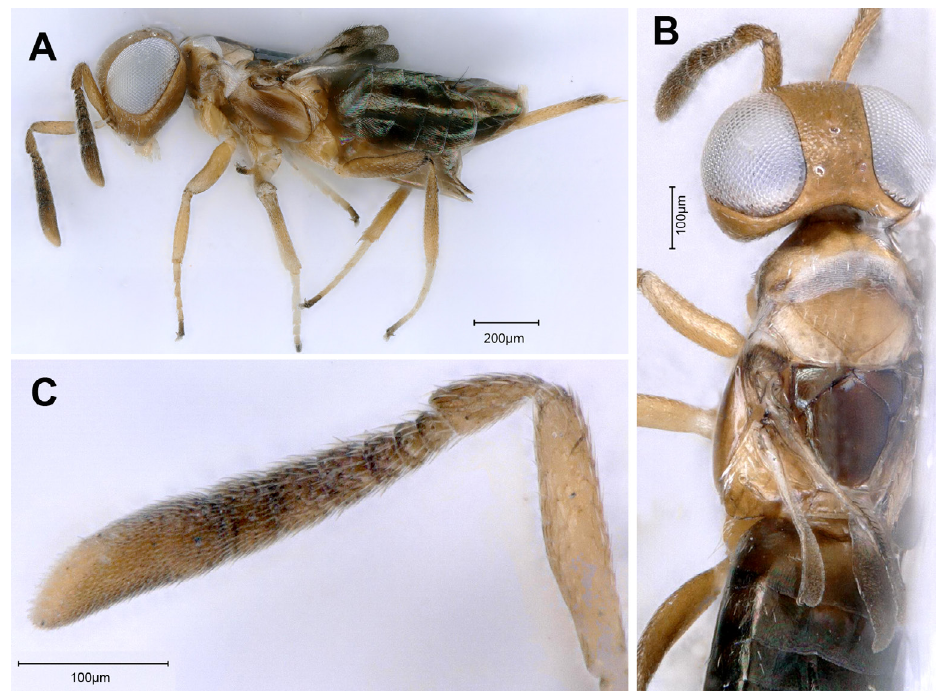
Fig. 4 . Echthroplexiella obscura (Hoffer, 1954). A . Female in lateral view. B . Head and mesosoma in dorsal view. C . Antenna of female.